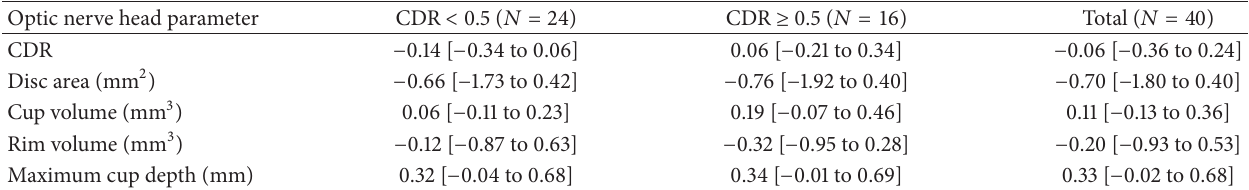
Table 2: Mean differences [limits of agreement (95% CI)] of stereometric optic nerve head parameters between HRT III and Kowa nonmyd WX3D assessment separated for the CDR < 0.5 group and the CDR ≥ 0.5 group and in